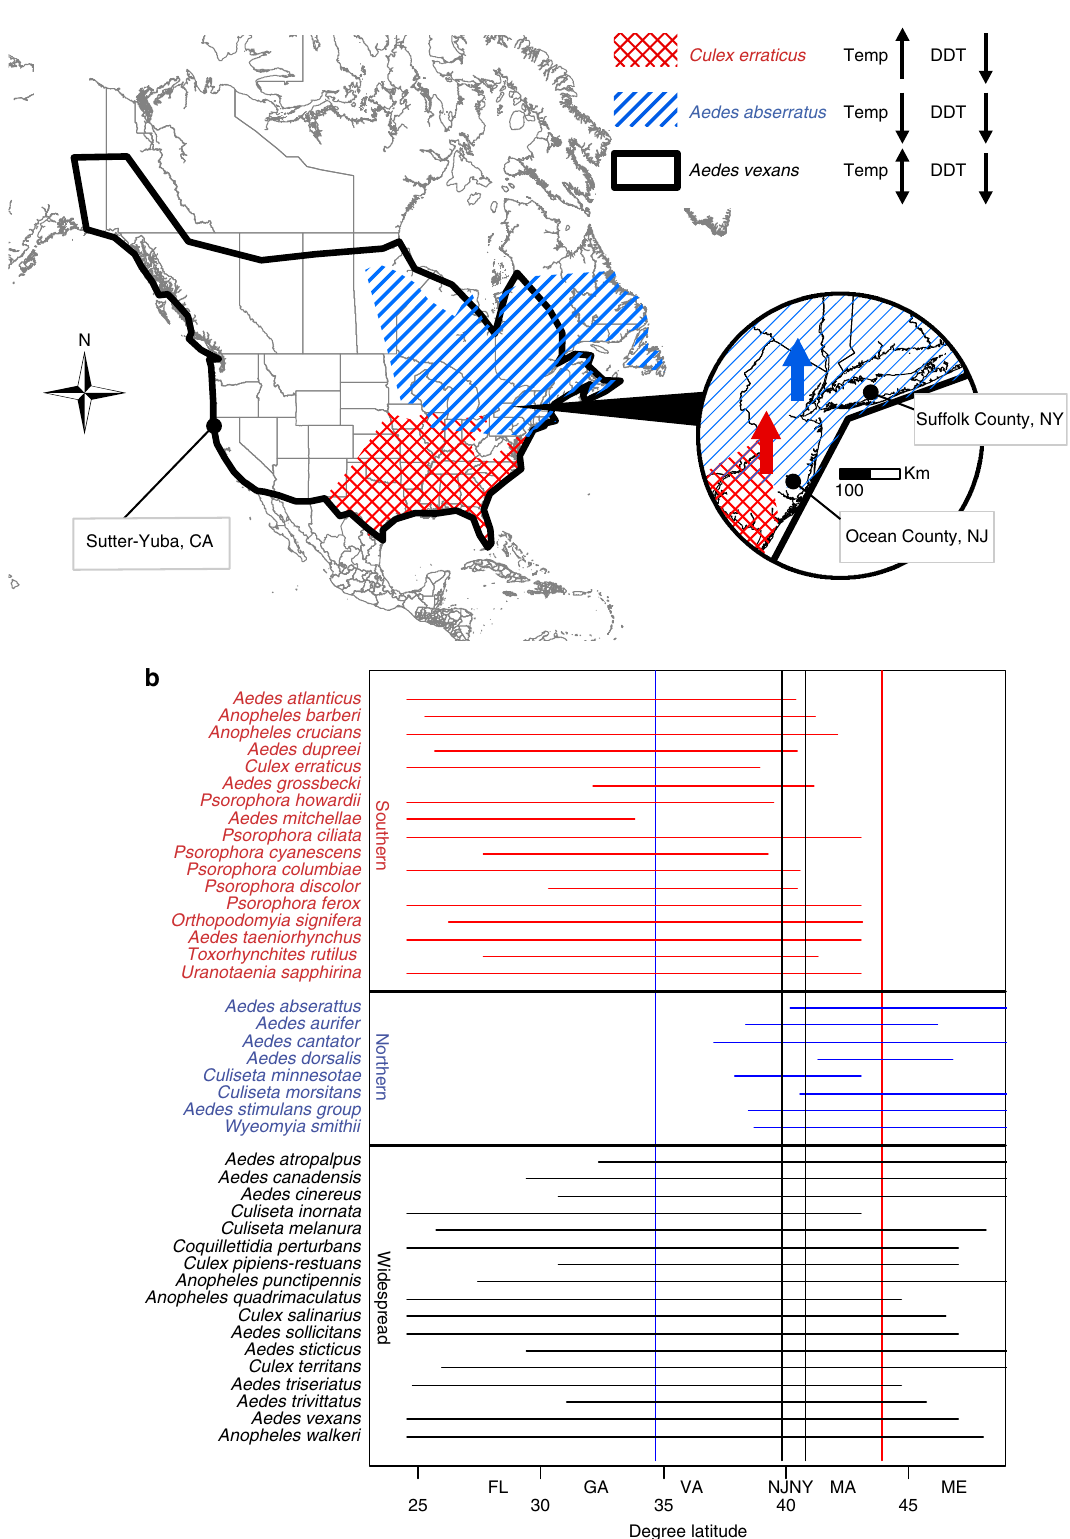
Figure 4 | Predicted changes in the geographic distributions and abundance of mosquitoes. ( a ) Colours on the map show distributions for representative Southern ( Culex erraticus ), northern ( Aedes abserratus ) and widespread ( Aedes vexans ) mosquito species and the three study areas. Black arrows indicate predicted changes (up or down) in the species richness and abundance of these groups of mosquitoes if changes were primarily driven by temperature (Temp) or DDT. In the inset map, red ( Culex erraticus ) and blue ( Aedes abserratus ) arrows show the expected shifts in these species populations with increased temperature relative to the study sites. ( b ) The geographic ranges of mosquito species based on Darsie and Ward 39 relative to geographic latitude and states, with the northern boundary of southern species given by the red vertical line and the southern boundary of northern species shown by the black